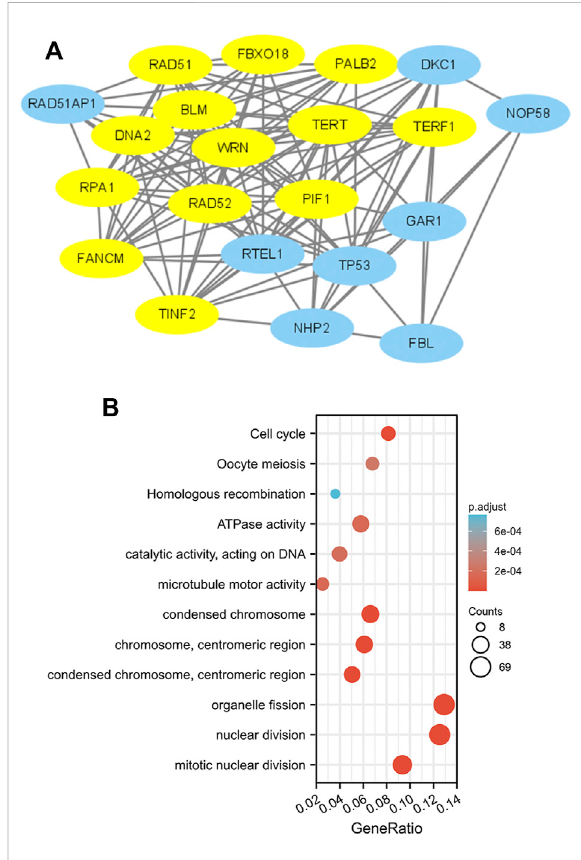
FIGURE 7 PPI networks and functional enrichment analyses. (A) A network of PIF1 and its coexpressed genes. (B) Functional enrichment analyses of 12 involved genes. PIF1 was associated with cytokine ‒ cytokine receptor